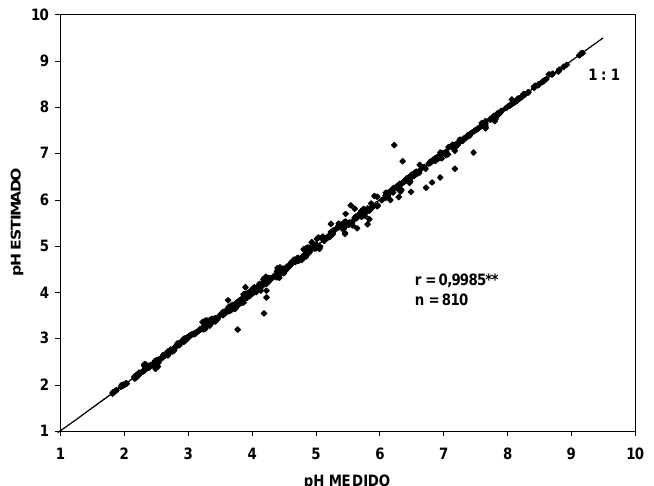
Figura 1. Relação entre os valores medidos de pH e os estimados pelo modelo polinomial de quarto